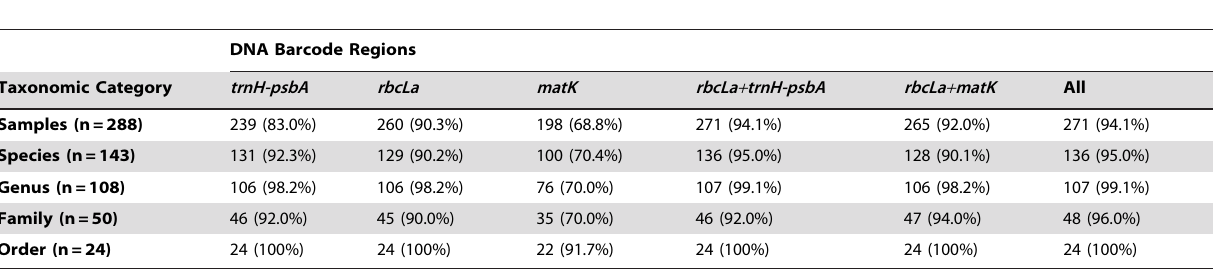
Table 1. Sequence recovery rates for 143 species of trees and shrubs in the Luquillo Forest Dynamics Plot, Puerto Rico.